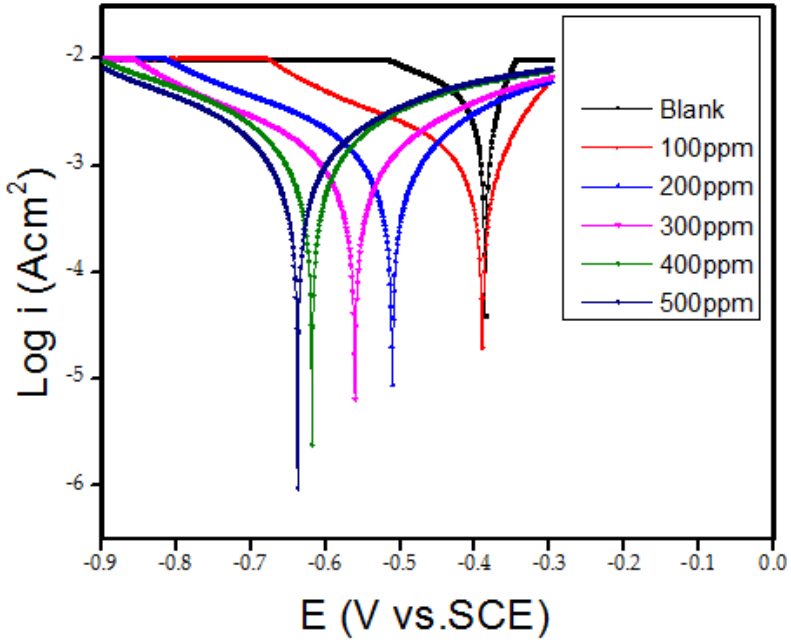
Figure 4. Potentiodynamic polarization curves for mild steel in the absence and presence of different concentrations of Cs-g-L-arginine (Tafel plot). Table 1. Potentiodynamic polarization